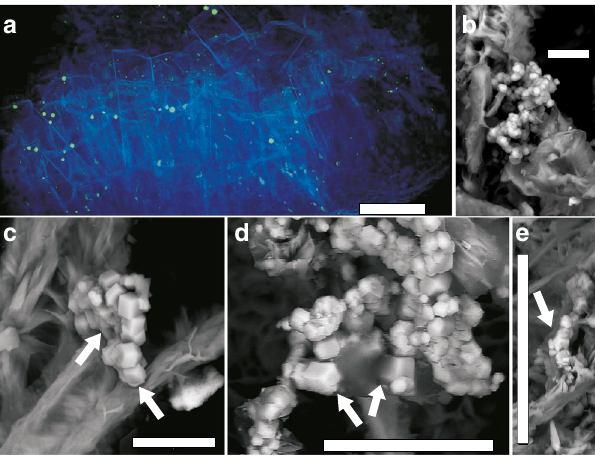
Fig. 5 Characteristics of pyrite and spatial pyrite-hypha relation. ( a ) Synchrotron Radiation X-ray Tomographic Microscopy